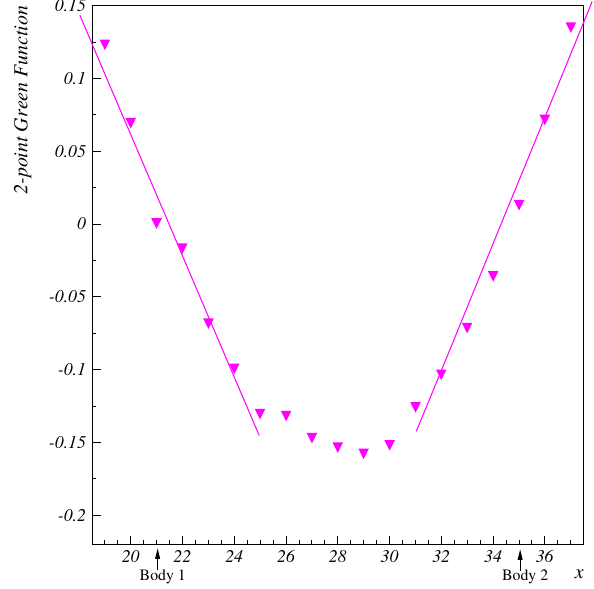
Fig. 6 Same as Fig. 5 but with the 1 / x – free-field – contribution subtracted. The lines illustrate the nearly linear trend of the potential